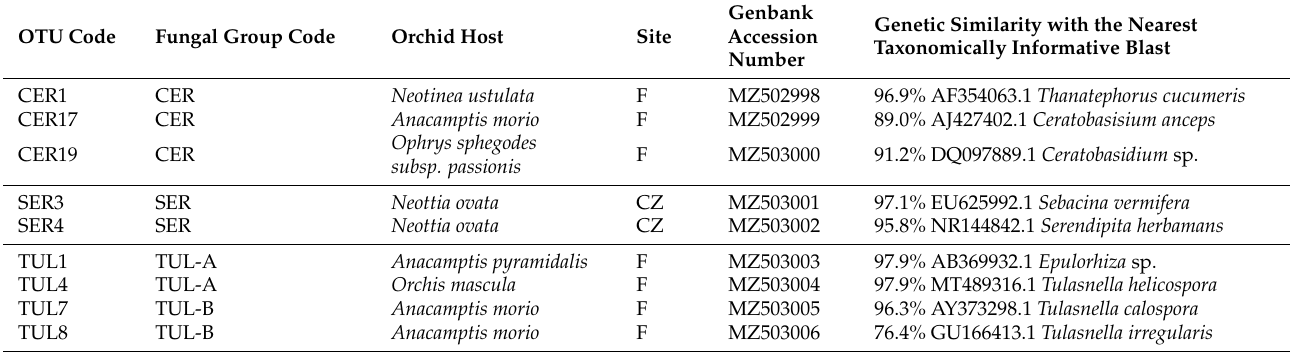
Table 1. Description of fungal isolates. Fungal groups: SER—family Serendipitaceae, CER—family Ceratobasidiaceae, TUL-A and TUL-B—two clades within Tulasnellaceae, see Figure 1A–C. Sites of orchid host origin: CZ—Czech Republic (49.1292N; 13.6591E), F—France (43.9669N; 3.4028E). OTU—operational taxonomic